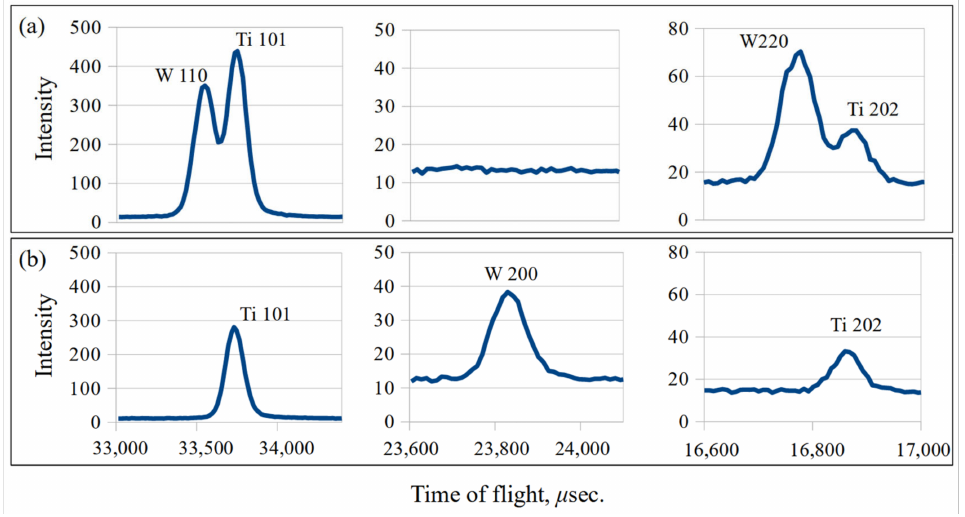
Figure 7. Comparison of the diffraction peaks in N-direction and S-direction. ( a ) N-direction: W110 and W220 appear. ( b ) S-direction: W110 and W220 disappear, and W200